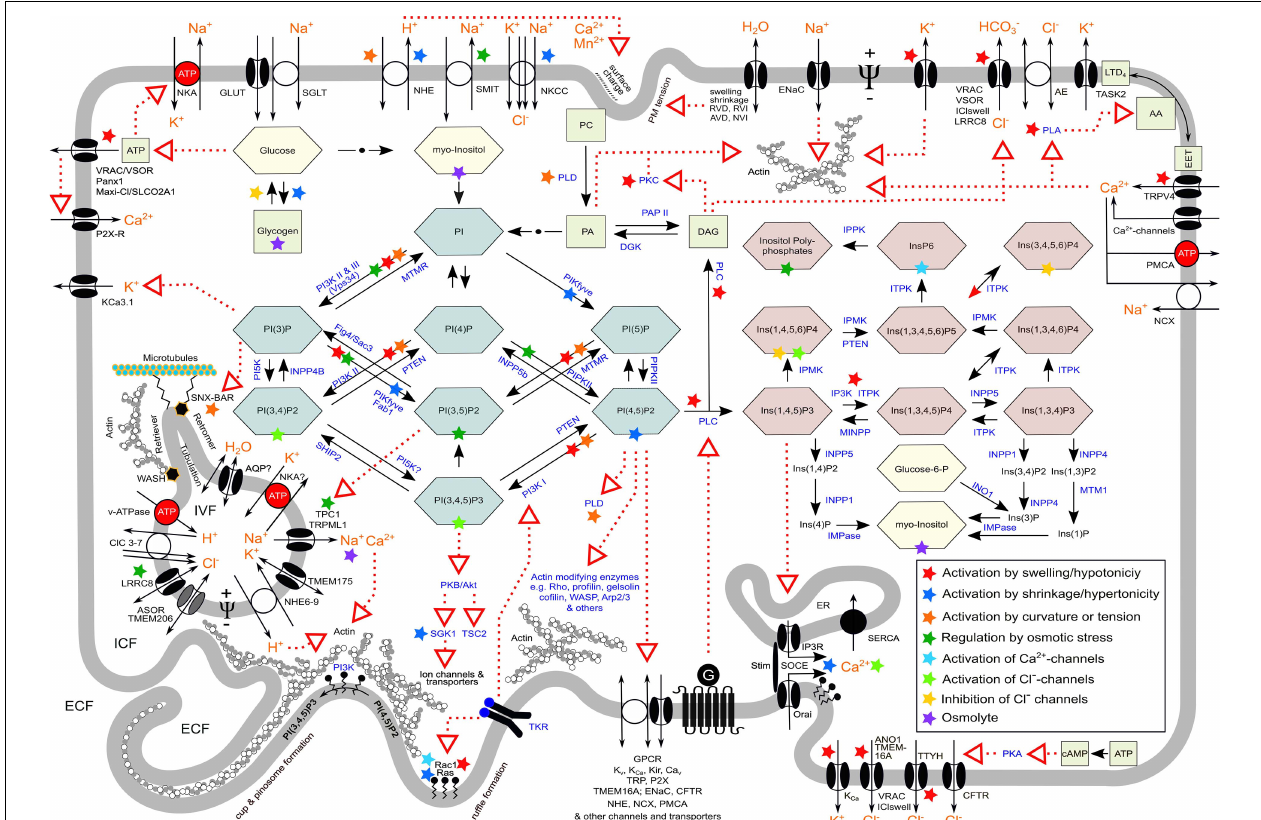
FIGURE 3 | Synopsis of various aspects in macropinocytosis and ion transport in cell volume regulation and vesicular volume regulation, which are also relevant in methuosis. Red dotted arrows indicate action/s on target/s; black arrows indicate metabolic conversion; green combs, phosphoinositides; red combs, inositolphosphates; yellow combs, sugars; green squares, important metabolites; orange letters, ion(s); blue letters, enzymes; ECF, extracellular fluid; ICF, intracellular fluid; IVF, intravesicular fluid; G, heterotrimeric G protein; TKR, tyrosine kinase receptor; NKA, Na + /K + -ATPase; SOCE, store-operated Ca 2 + entry; (cid:57) , transmembrane electrical potential difference. For the meaning of colored asterisks, see insert in the right lower part. For details, nomenclature, and further abbreviations, see text and list of abbreviations.